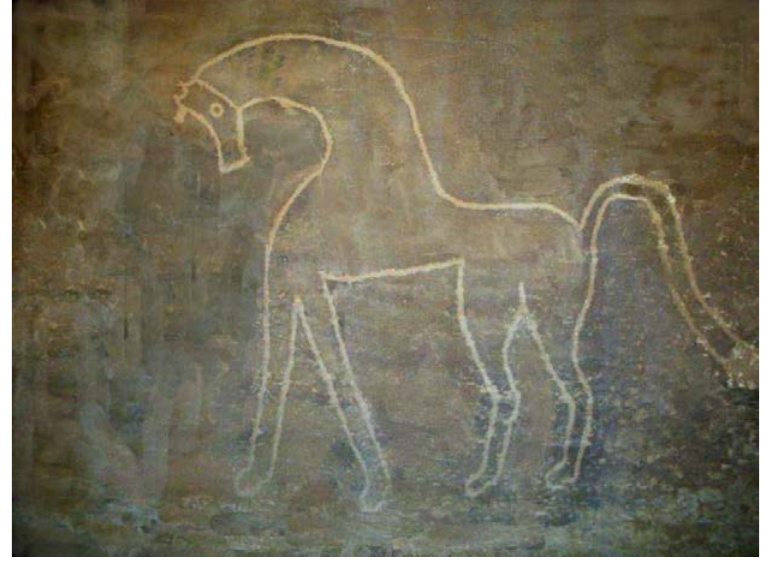
Figure 33. The stallion is exactly the same today as it was 3000 years before, as shown in this petroglyphs of a horse, located near Tayma, northwest of Saudi Arabia.